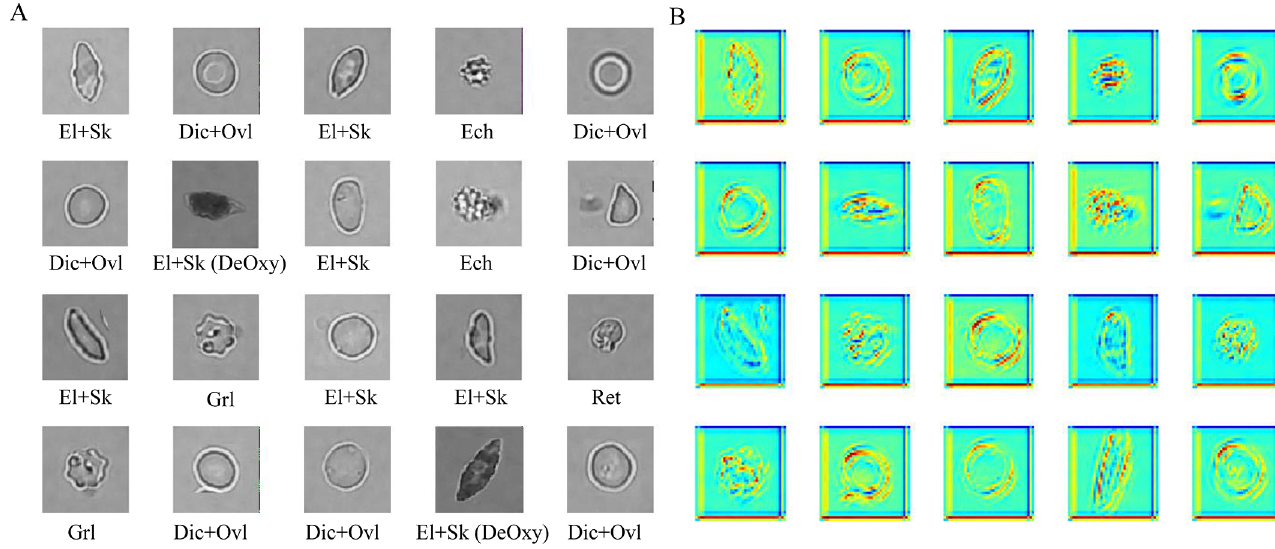
Fig 19. Snapshots of feature maps for layer 5 including the deoxygenated category. ( A ) originalimages in batch 1. ( B ) feature maps in 5th layer.